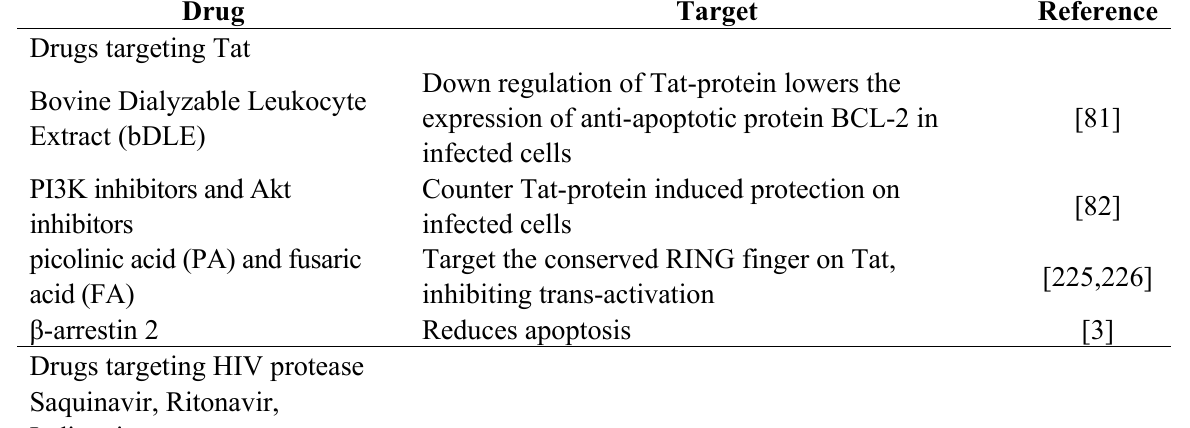
Table 3. Drugs targeting apoptosis in